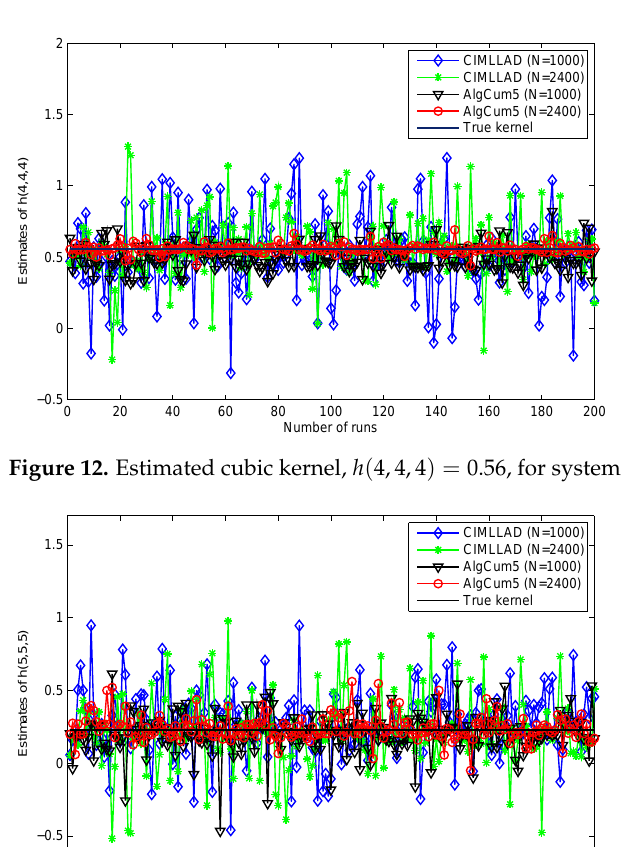
Figure 11. Estimated cubic kernel, h ( 3,3,3 ) = − 0.688, for system II.